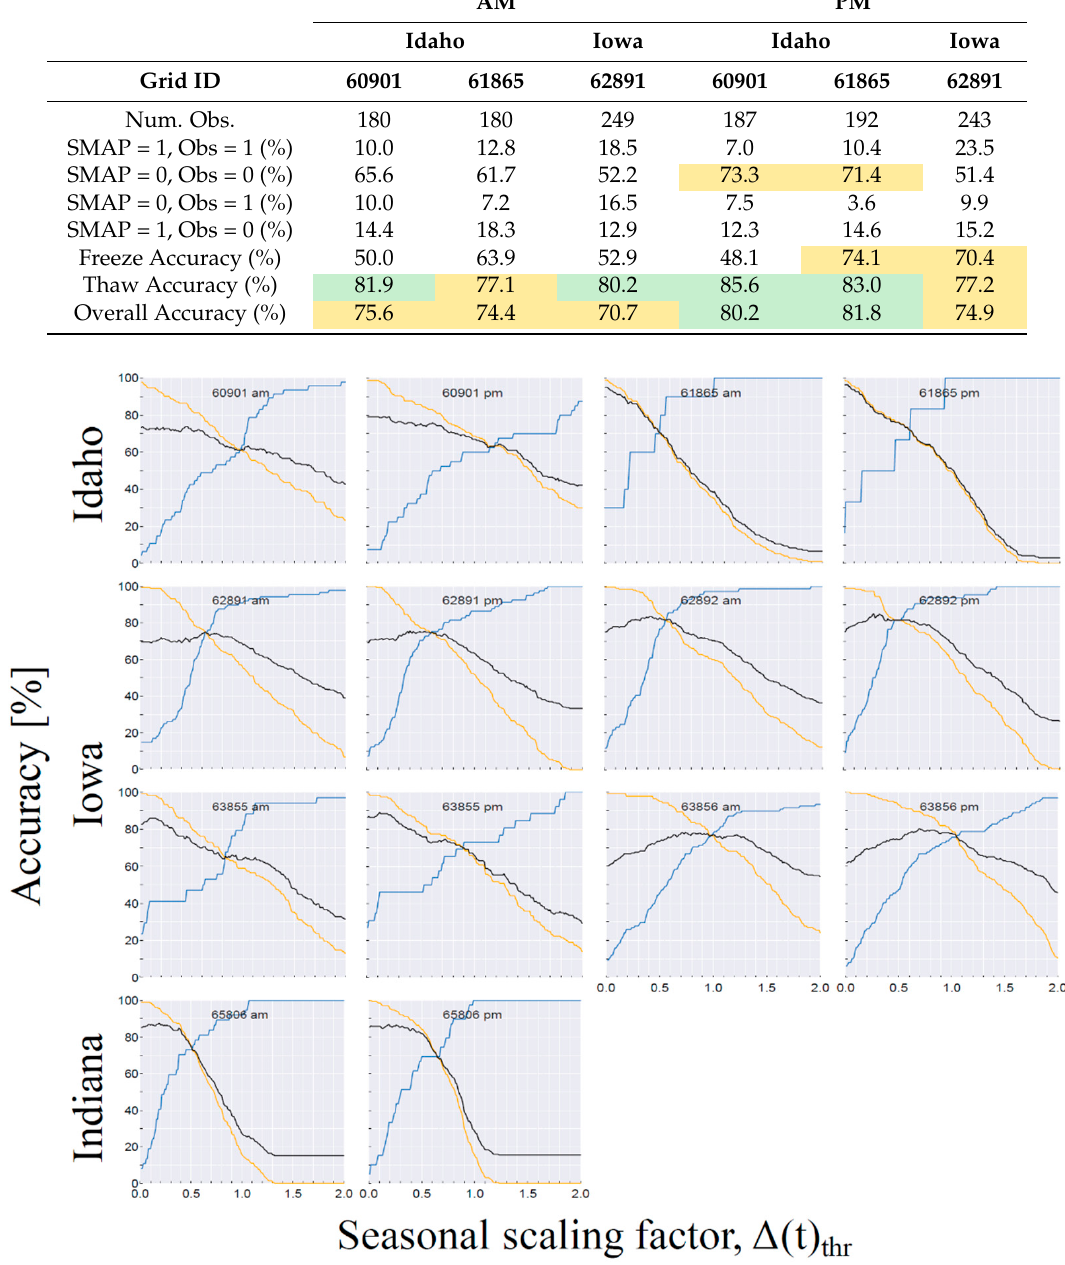
Figure 8. Classification accuracy (freeze accuracy: blue, thaw accuracy: orange, overall accuracy: black) as function of Δ (t) thr during winter (October–March).